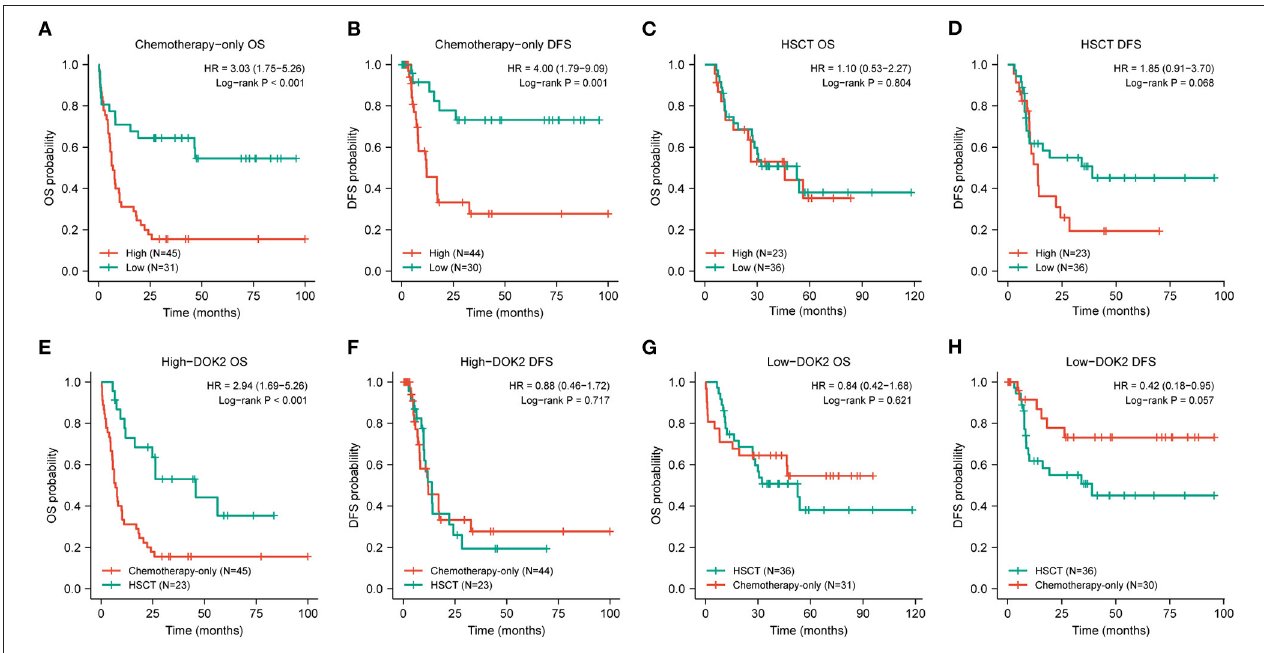
FIGURE 3 | Prognostic value of DOK2 in treatment modalities. (A,B) Kaplan–Meier survival analysis for OS and DFS in the chemotherapy-only group. (C,D) Kaplan–Meier survival analysis for OS and DFS in the HSCT group. (E,F) Comparison of treatment methods for OS and DFS in the DOK2 high group. (G,H) Comparison of treatment methods for OS and DFS in the DOK2 low group.